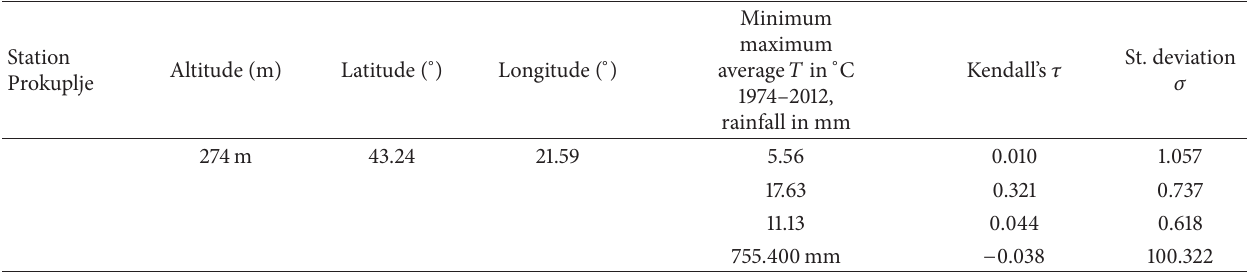
Table 1: Trends of four time series data from meteorological station Prokuplje with Kendall 𝜏 rank correlation. Significance level alpha is 0.05 or 5% of inputted data.